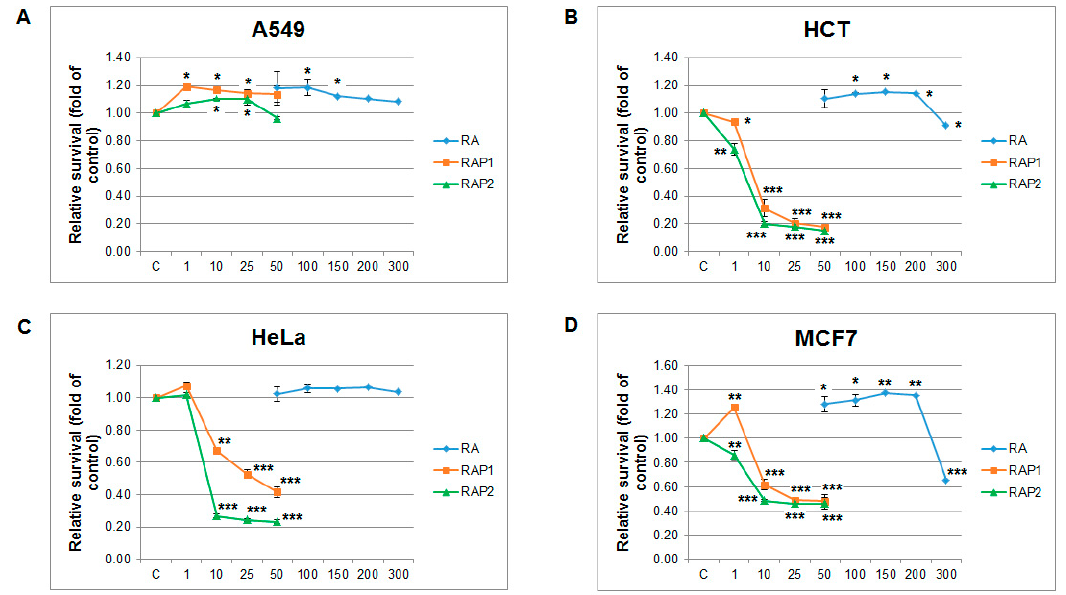
Figure 1. Effect of RA (c = 50–300 µ M) and compounds RAP1 , RAP2 (c = 1–50 µ M) on the metabolic activity of A549 ( A ), HCT116 ( B ), HeLa ( C ) and MCF-7 ( D ) cells using MTS assays. Data were obtained from three independent experiments, and significant differences were marked as * p < 0.05, ** p < 0.01, *** p < 0.001 versus control cells (untreated).